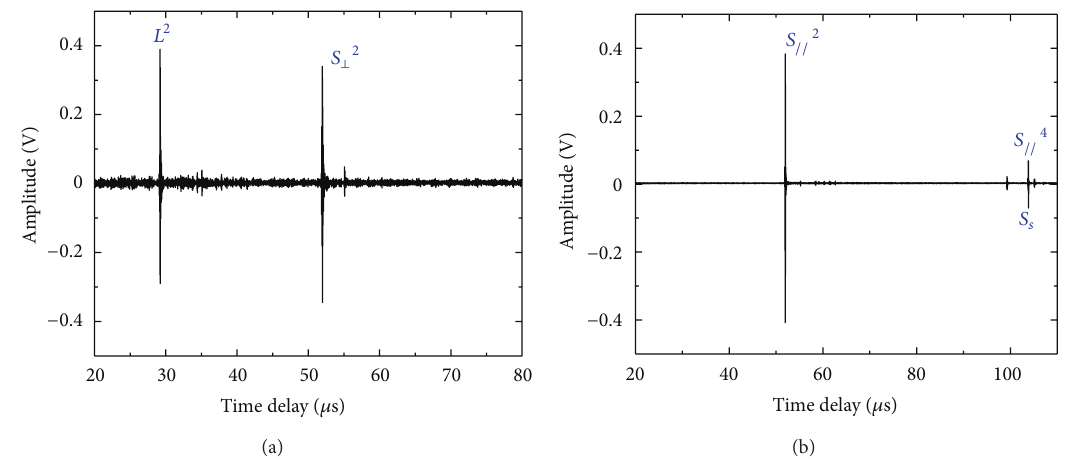
Figure19:(a)Longitudinalwaveechosignal( 𝐿 )andshearwaveechosignal( 𝑆 ⊥ ),reflectedfromtheprobe’send.Wavesgeneratedandreceived by one IUT; (b) shear wave echo signal ( 𝑆 // ), reflected from the probe’s end. Waves generated and received by the other IUT. Superscripts 2 and 4 designate the first and second round trip waves, respectively.